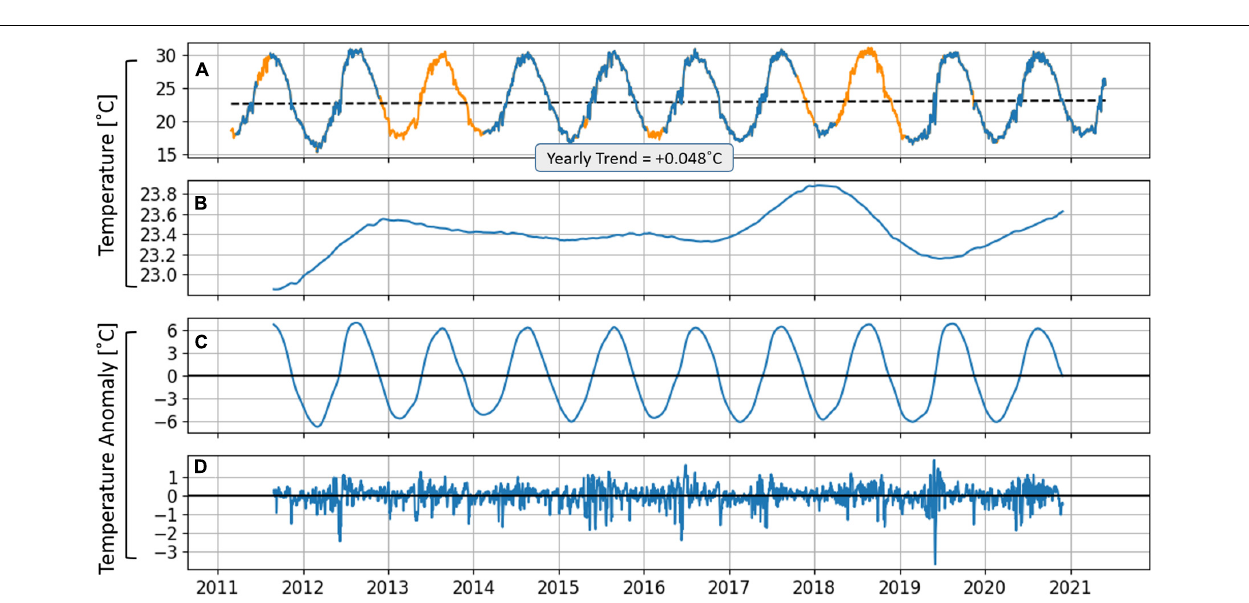
FIGURE 3 | Daily averaged surface water temperature (A) – Hadera CTD values (blue) and missing data completed using multi parameter regression (orange). Calculated trend (B) , seasonal (C) , and irregular (D) terms achieved using the X11 decomposition method. Yearly linear trend accepted with the seasonal Mann-Kendall test of 0.048 ◦ C ( p = 0, z = 10.92) presented in panel (A) (dashed black line and text box).